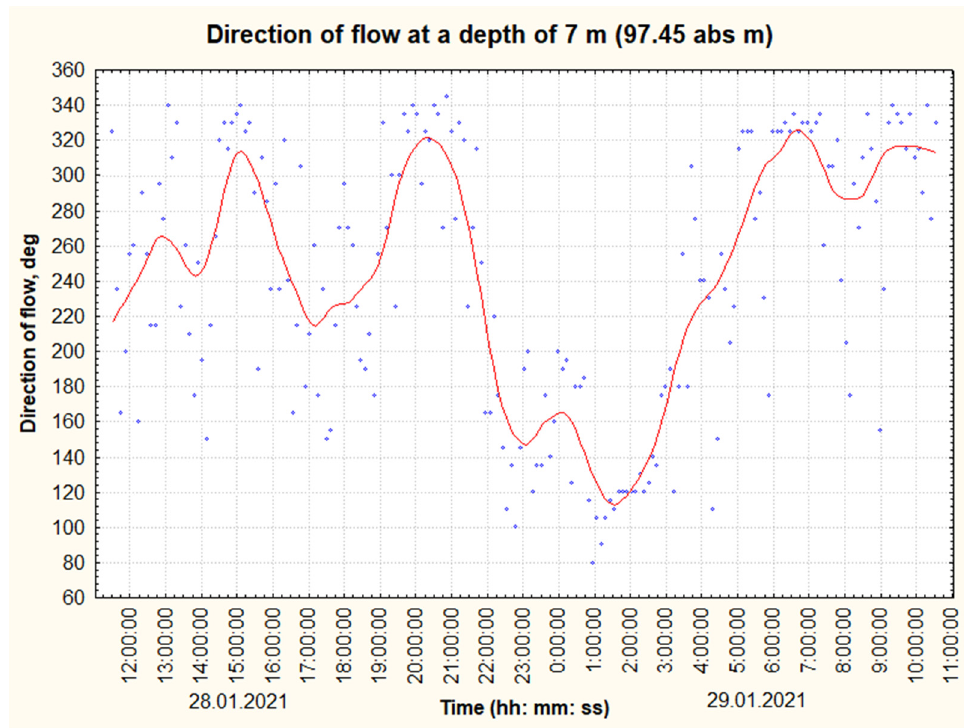
Figure 5. Changes in the flow direction (degrees).